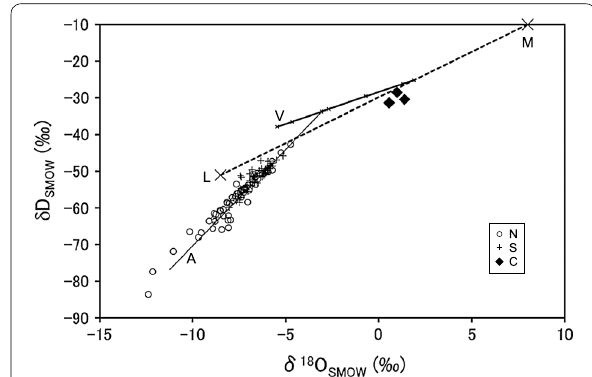
Fig. 9 Isotopic ratio of H 2 O in fumarolic gases compared with model calculation. M: isotopic ratio of magmatic H 2 O (900 °C), L: isotopic ratio of local meteoric water (15 °C), V: isotopic ratio of H 2 O vapor (265 °C), A: condensation of H 2 O vapor at 100 °C